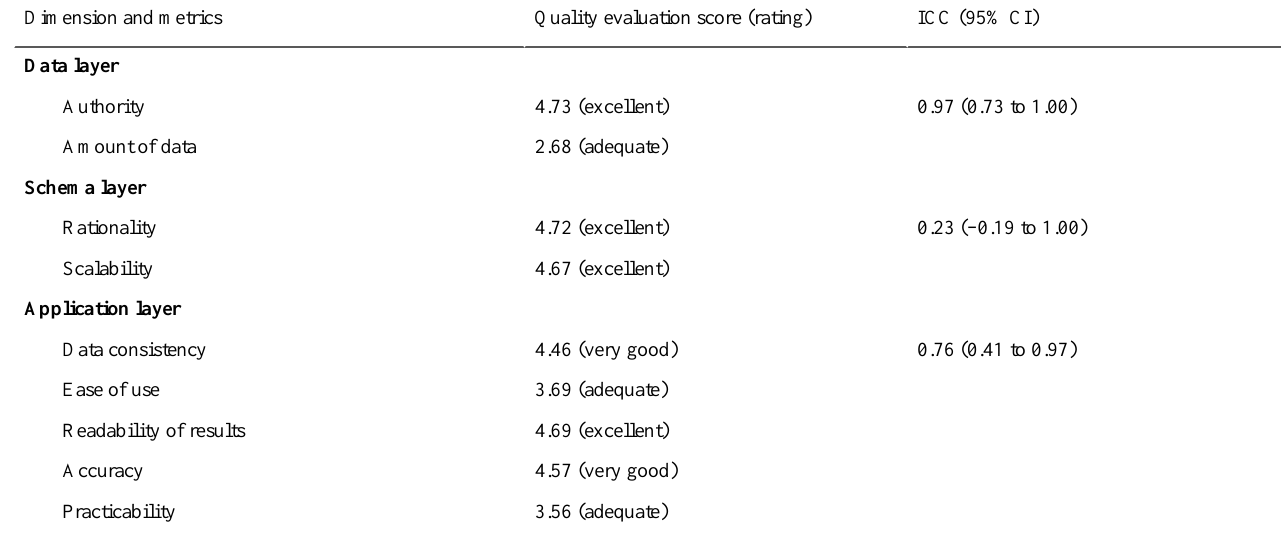
Table 4. Quality evaluation score and intraclass correlation (ICC) score of the digestive system tumor knowledge